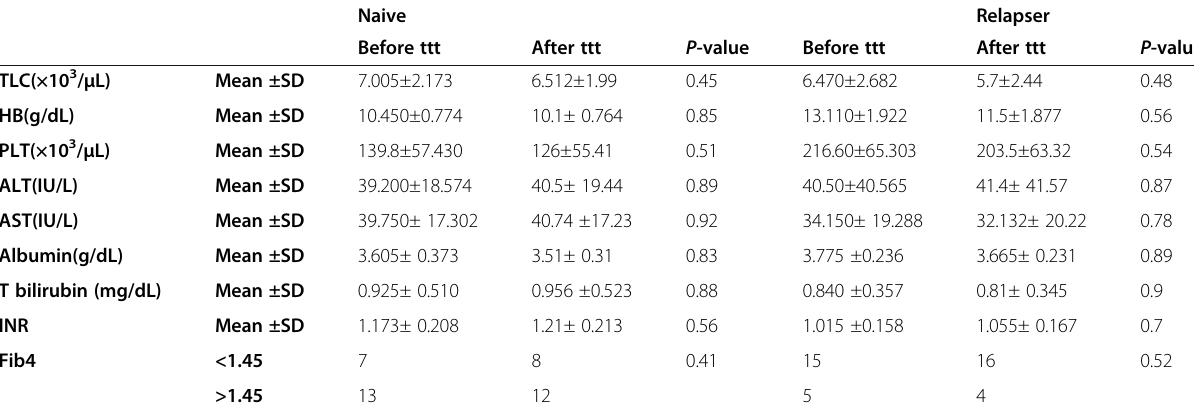
Table 3 Comparison between baseline and post-treatment different laboratory parameters and FIB-4 in both naive and relapse group of patients